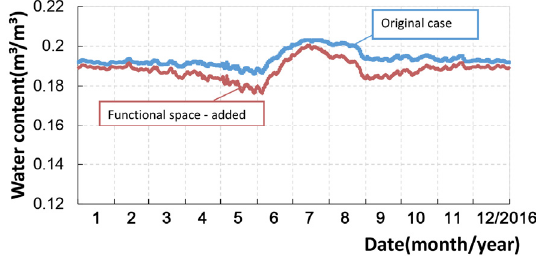
Figure 14. Point 1—water content change.